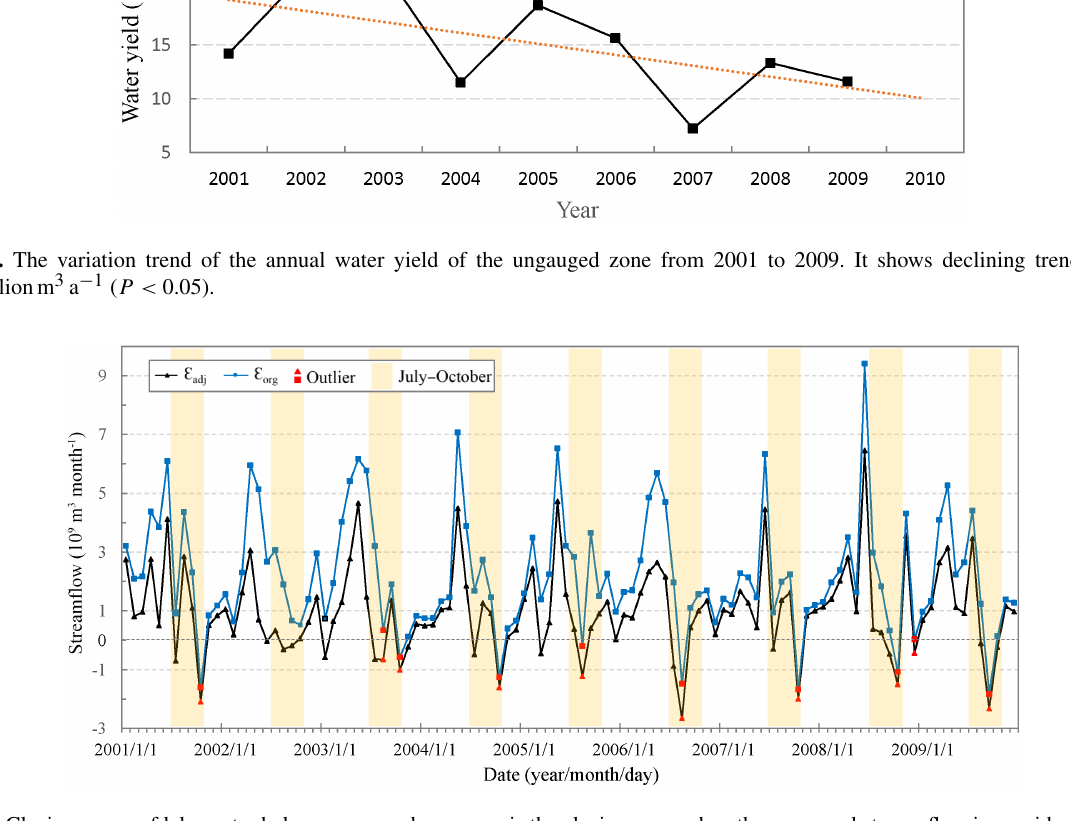
Figure 9. Closing errors of lake water balance: ε org and ε adj . ε org is the closing error when the ungauged stream flow is considered and ε adj is the closing error when the ungauged stream flow is omitted. Outliers are the point pairs, of which ε org is smaller than ε adj . The outliers are different from the other point pairs, of which the ε org is larger than ε adj